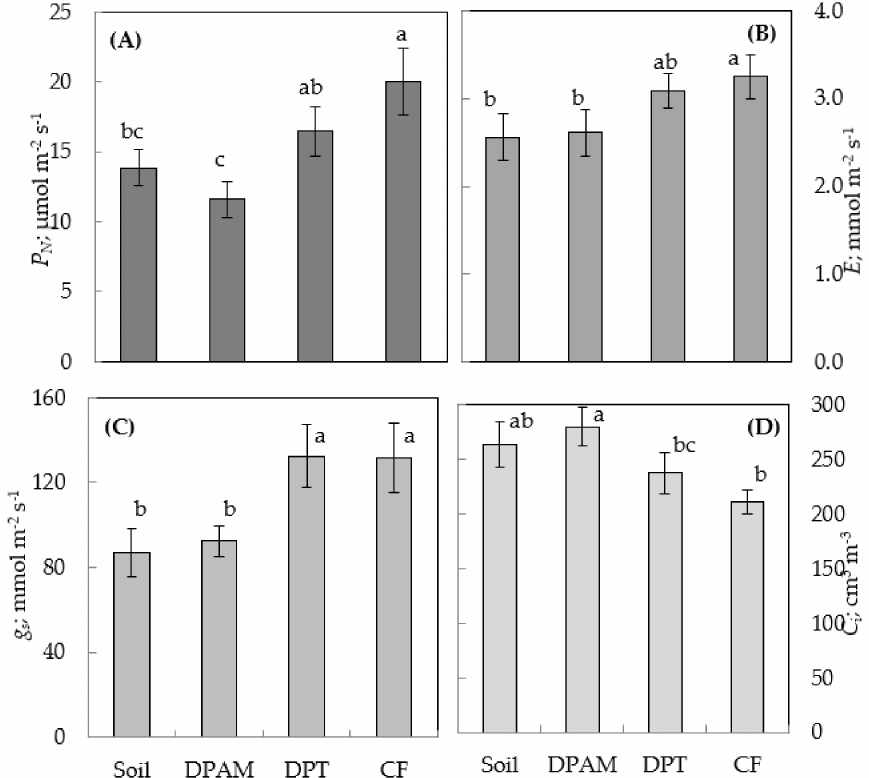
Figure 3. Effects of the culture substrates on photosynthesis parameters in leaves of melon